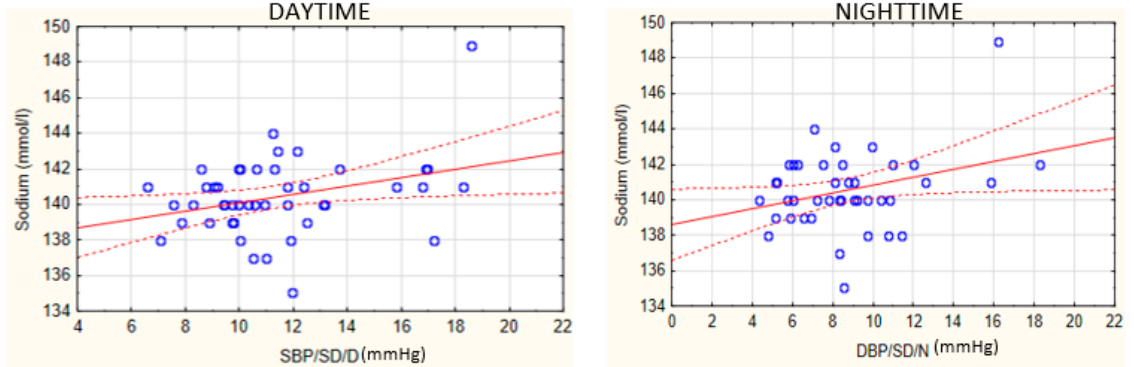
Figure 2. Correlations between BP parameters and the concentration of sodium. SBP, systolic blood pressure; DBP, diastolic blood pressure; SD, standard deviation; D, daytime; N, nighttime. Blue dots represent the data. The red dotted lines represent the confidence interval and the red line stands for the linear trend.